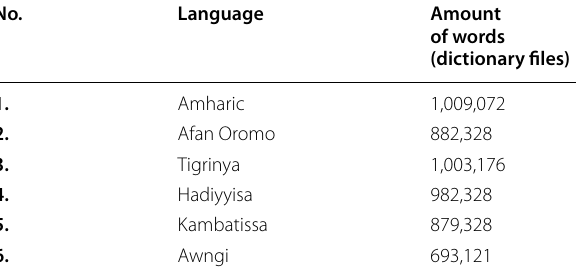
Table 1 Word dictionaries for the languages